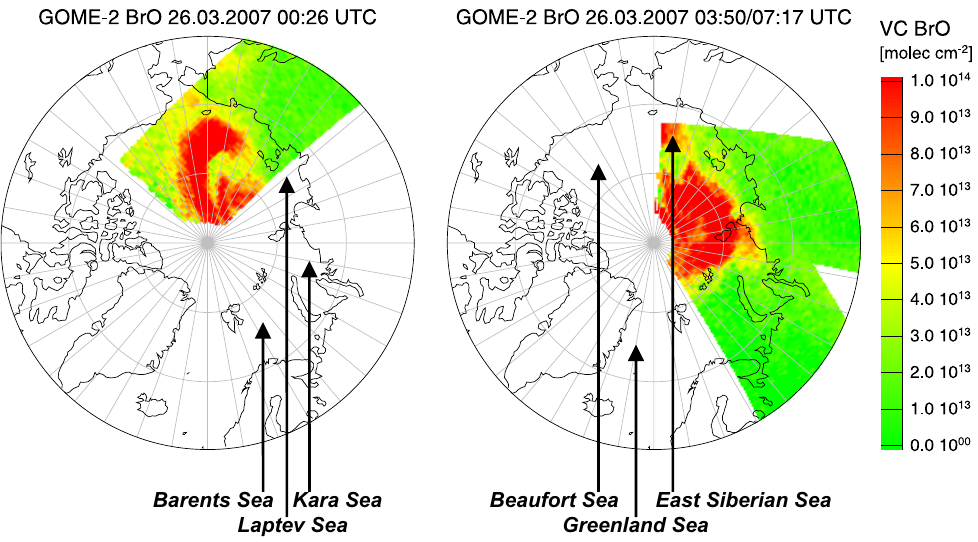
Fig. 3. Above figures show three satellite orbits, which have been used as input to initialise the FLEXPART model calculations. For the second source region, two orbits have been combined to cover the complete BrO